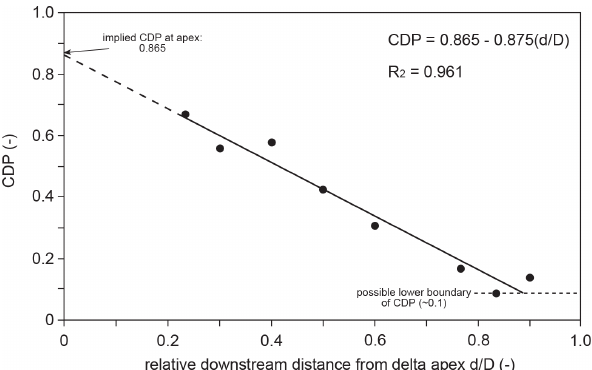
Figure 9. Relationship between CDP and downstream distance from the delta apex. Distance is noted relative to the total distance between the delta apex and the shoreline (relative distance d/D , with d being downstream distance from delta apex and D total dis- tance between delta apex and shoreline). The derived linear function suggests a CDP of ∼ 0.9 near the delta apex ( d/D = 0). CDP is at a minimum (0.10–0.15) in the distal delta ( d/D > 0 . 8).